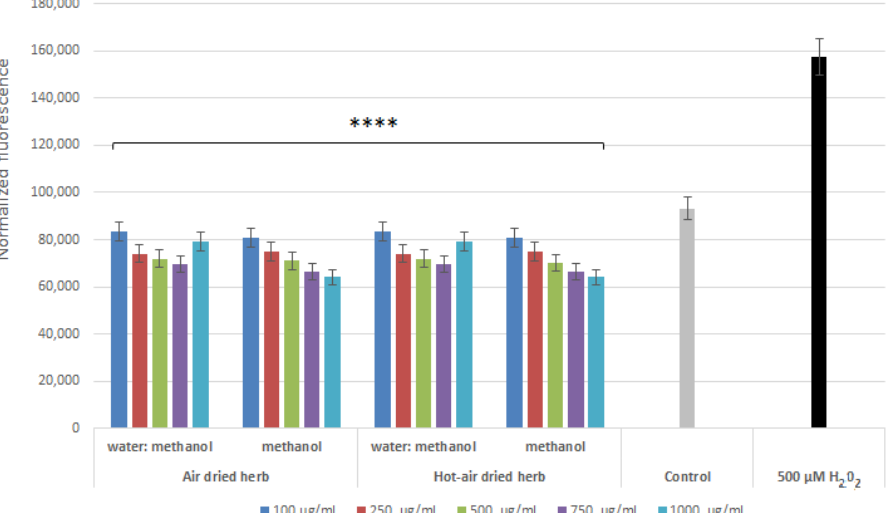
Figure 4. Effect of B. officinalis extracts on DCF fluorescence in HaCaT cells. Data are the means ± SD of three independent experiments. **** p < 0.0001 versus the control.